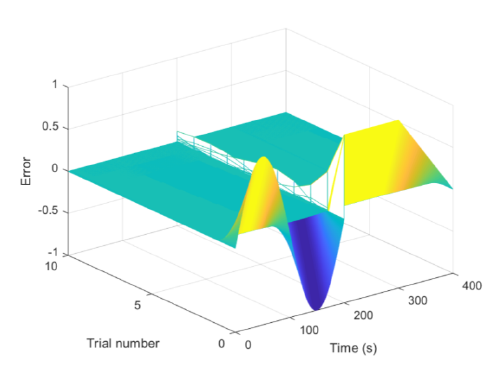
Figure 2. Surface variation of tracking error of norm-bounded uncertainty system with time and iteration times.